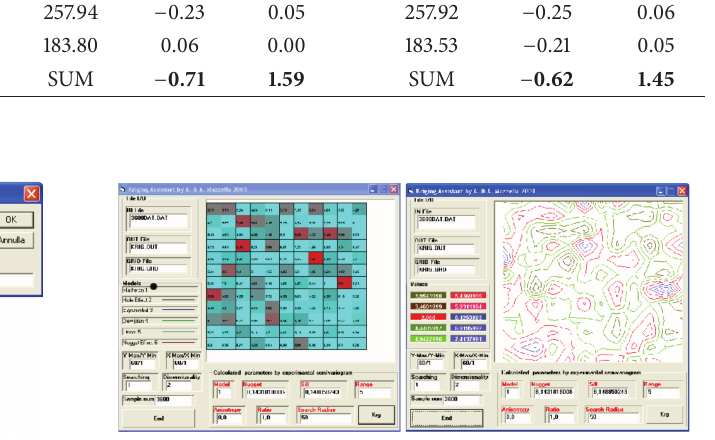
Figure 17: On the left, the experimental semivariogram calculus result is shown; on the right, the panel for the automatic interpre- tation technique selection is shown.